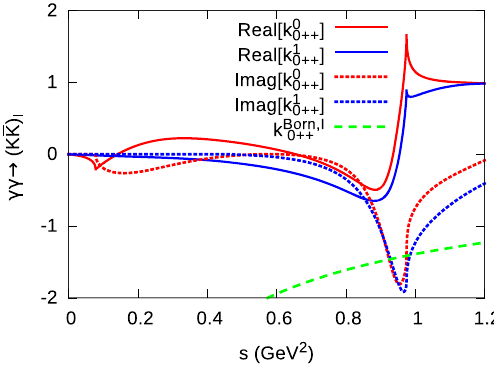
Fig. 13 Dispersive γγ → ( K ¯ K ) I S -waves with I = 0 , 1 without the Born amplitude which is shown